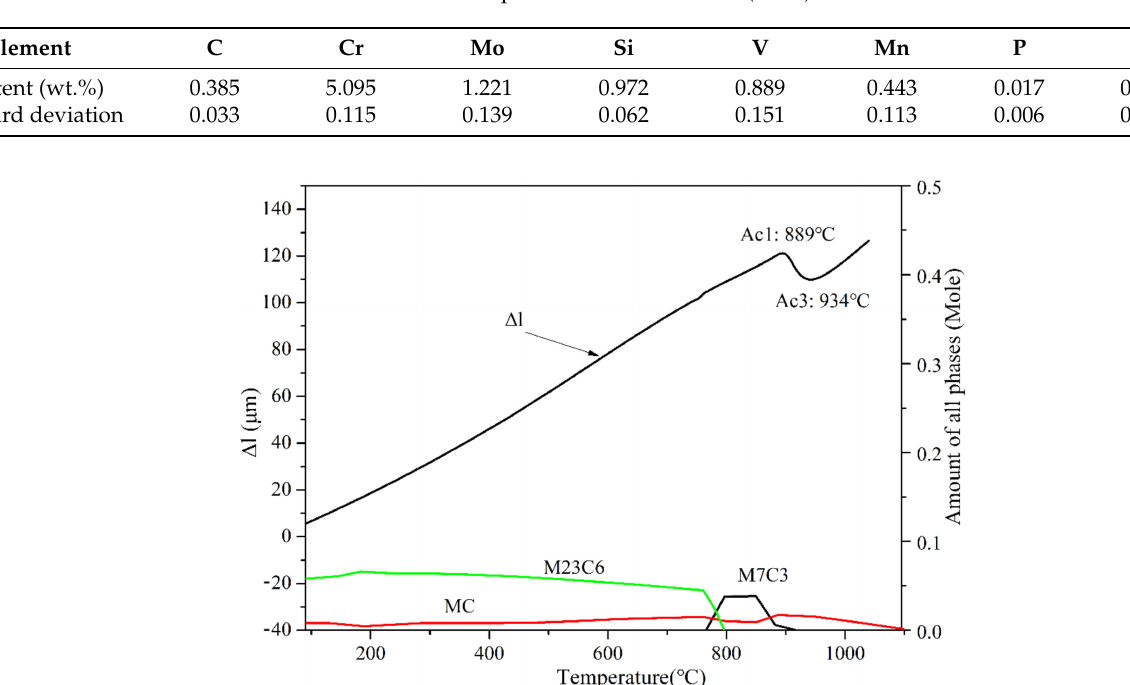
Table 1. The chemical composition of the H13 steel (wt.%).